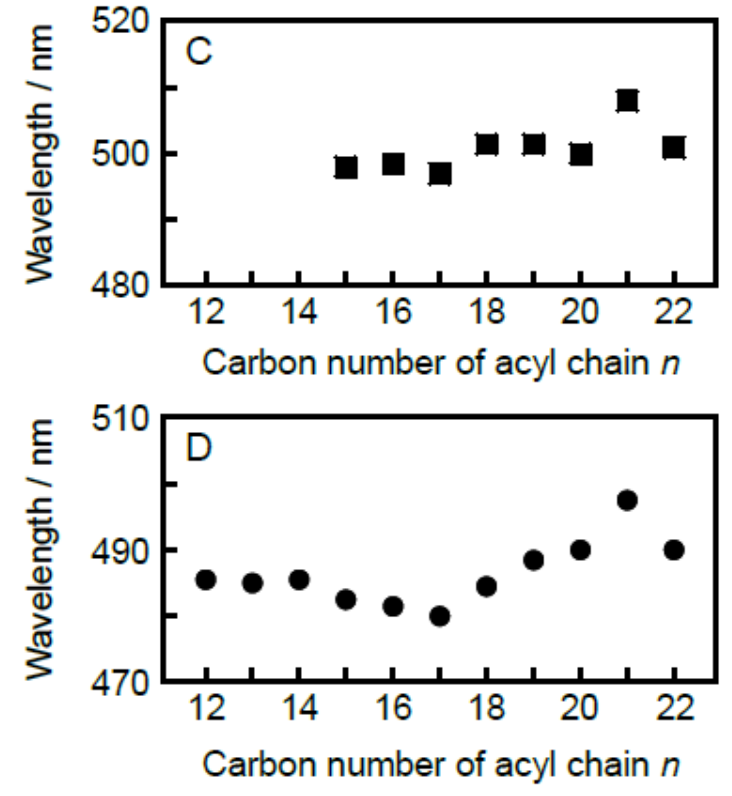
Figure 6. Acyl-chain length ( n ) dependence of λ min caracteristics for each bilayer phase state: Figure 6. Acyl ‐ chain length ( n ) dependence of  min caracteristics for each bilayer phase state: ( A ) ( A ) lamellar gel (L β (cid:48) ) phase, ( B ) ripple gel (P β (cid:48) ) phase, ( C ) interdigitated gel (L β I) phase, ( D ) liquid lamellar gel (L  ′ ) phase, ( B ) ripple gel (P  ′ ) phase, ( C ) interdigitated gel (L  I) phase, ( D ) liquid crystalline (L  ) phase. Here,  min means the wavelength at which a local minimum was observed in crystalline (L α ) phase. Here, λ min means the wavelength at which a local minimum was observed in each second derivative spectrum, and open symbols are used in the pannels ( A ) and ( B ) to repre ‐ each second derivative spectrum, and open symbols are used in the pannels ( A , B ) to represent λ min sent  min for minor peaks. for minor